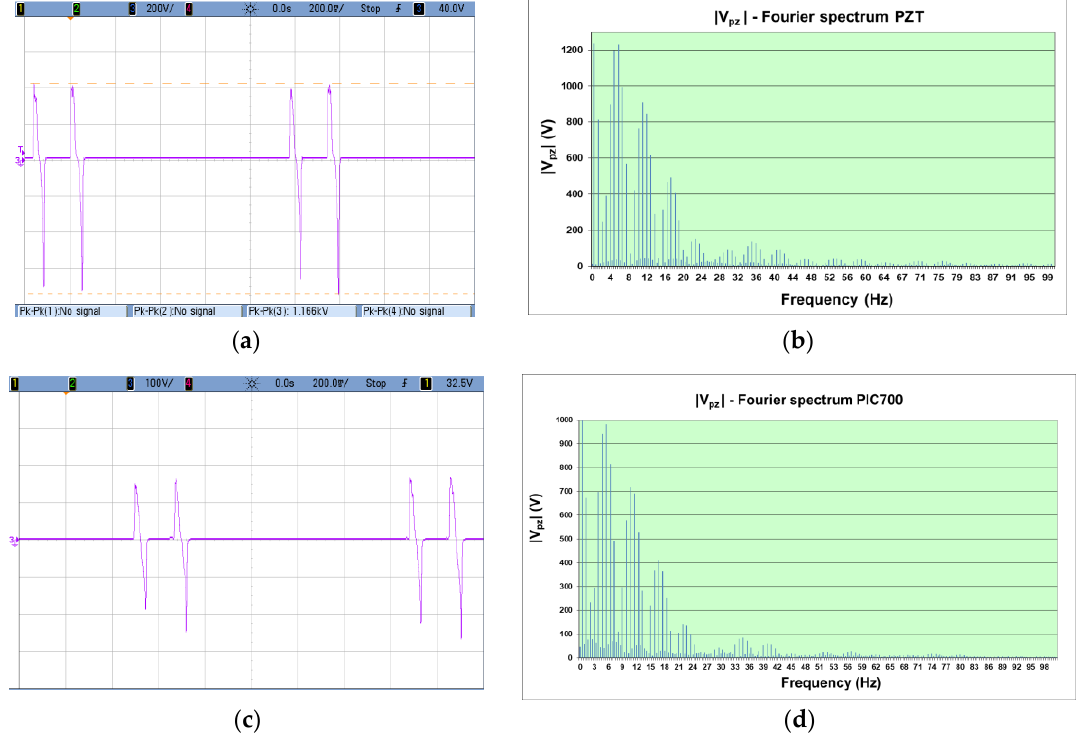
o ) in the PZT ceramics.